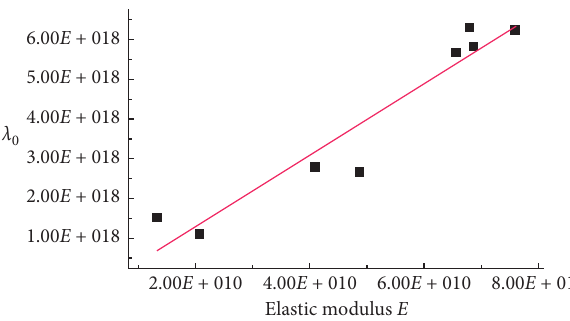
Figure 6: Relation between bending rigidity coefficient and elastic